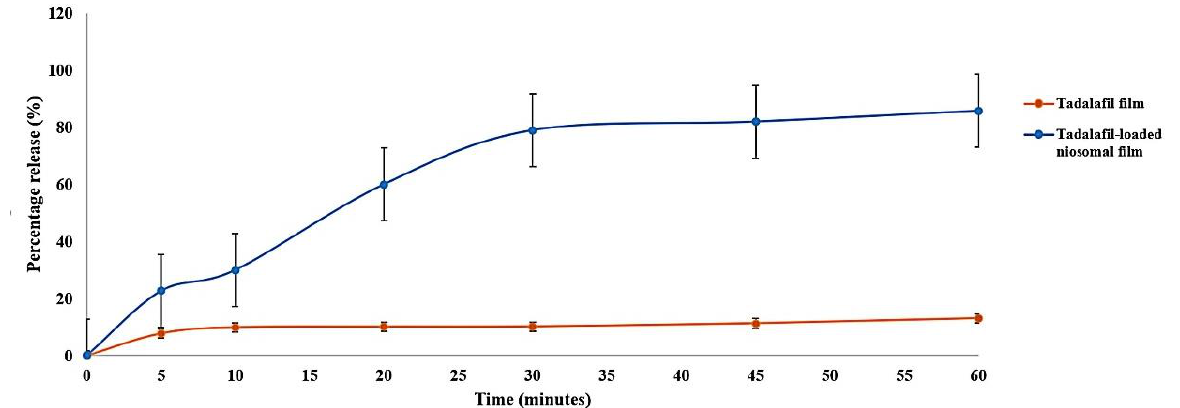
Figure 4. In-vitro percentage release (%) of tadalafil from the niosomal film in comparison with its release from the marketed tablet as function of time (minutes).